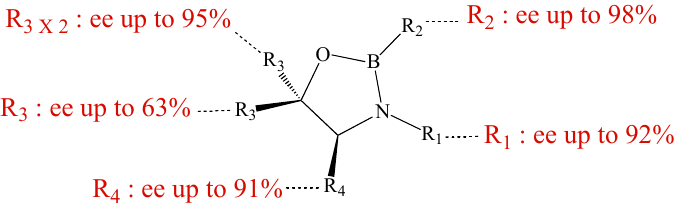
Figure 2. Supported oxazaborolidines by different substituents on